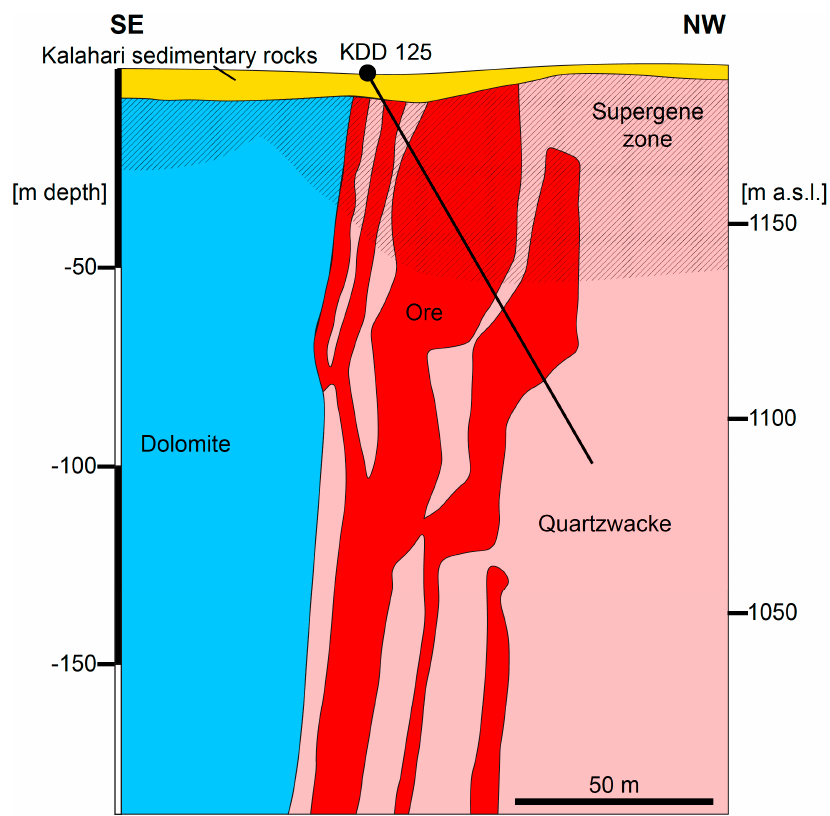
Figure 4. Schematic geological section of the Kihabe mineralized body (modified from [11]). Ore = outline of the ore bodies based on drillcore 3D modeling [11]. See Figure 3 for the location of the cross section within the prospect